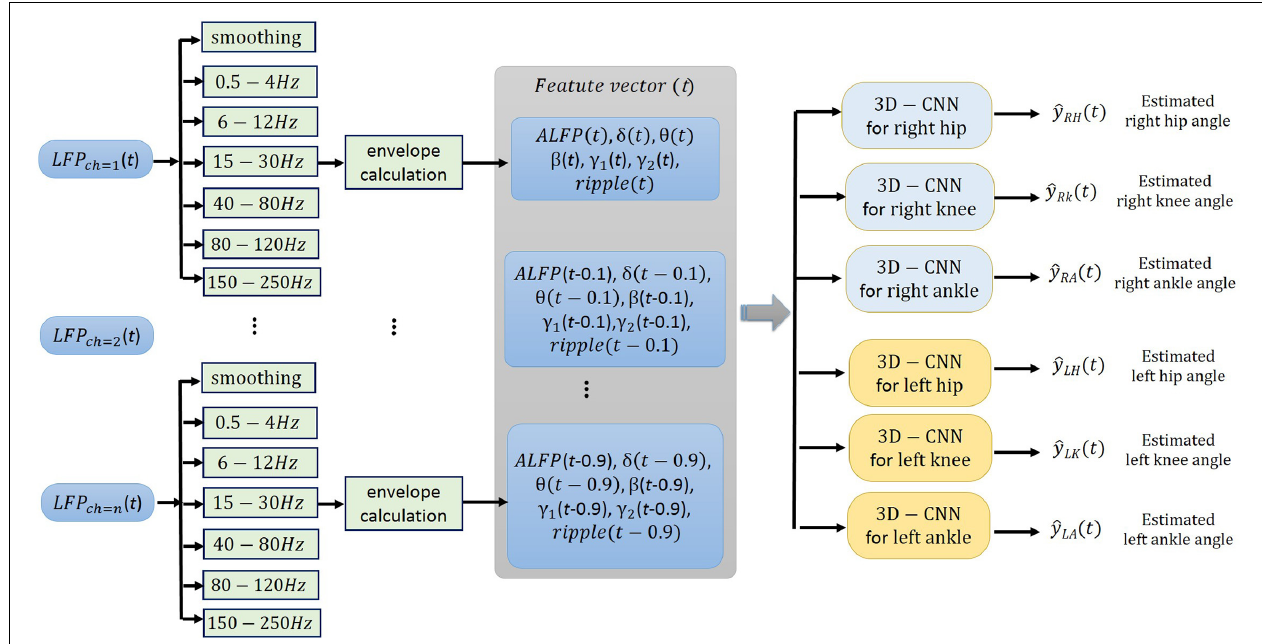
FIGURE 5 | Schematic illustration of the neural signal processing. The smoothed amplitude of LFP signal (ALFP), envelopes of LFP signals at six frequency bands including δ (0.5-4 Hz), θ (6-12 Hz), β (15-30 Hz), γ (40-80 Hz), high- γ (80-120 Hz), and ripple (150-210 Hz), and their ten time lags ( t , t − 100 ms , ... , t − 900 ms ) constitute the three-dimensional feature matrix [channel × time lag × (ALFP + average of signal envelope in each frequency band)].